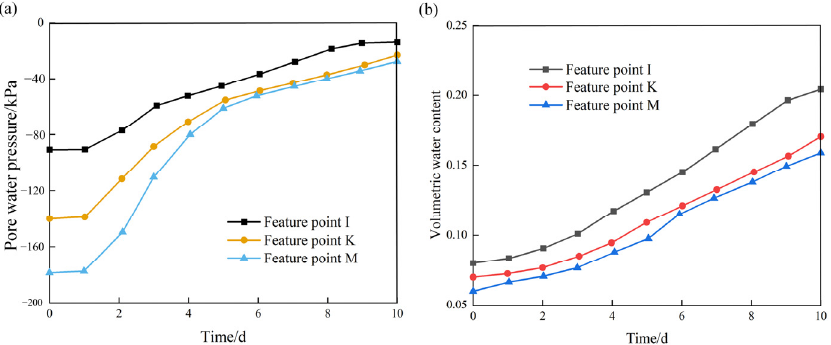
Figure 9. Variations in pore water pressure and volumetric water content with time at three positions on the slope without protection: ( a ) pore water pressure; ( b ) volumetric water content.